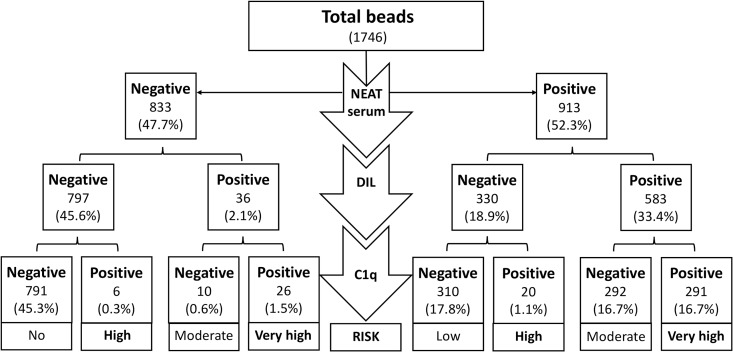
Stratification of the risk regarding positive bead results after neat serum, diluted serum and C1q test.A total number of 1746 beads were distributed according positive (+) and negative (-) results after neat (N), 1/160 diluted (DIL) serum and C1q test. The combination of the results render 8 profiles with potential different risk. The absolute number of beads are in parentheses and the percentage of total beads in every profile are shown.